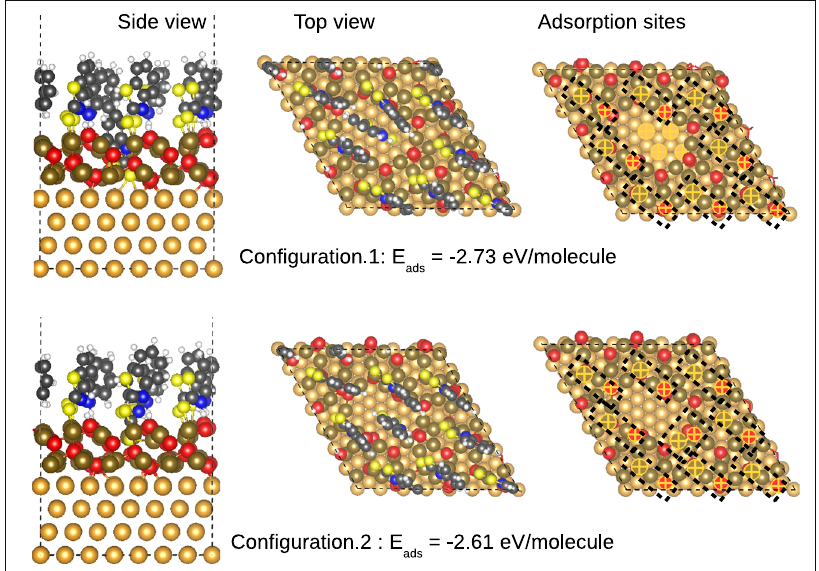
Fig. 4 Con fi gurations 1 and 2 of MBTH form adsorbed on the partially oxide-covered copper surface. Illustration of side and top views and different adsorption sites on partially oxide-covered